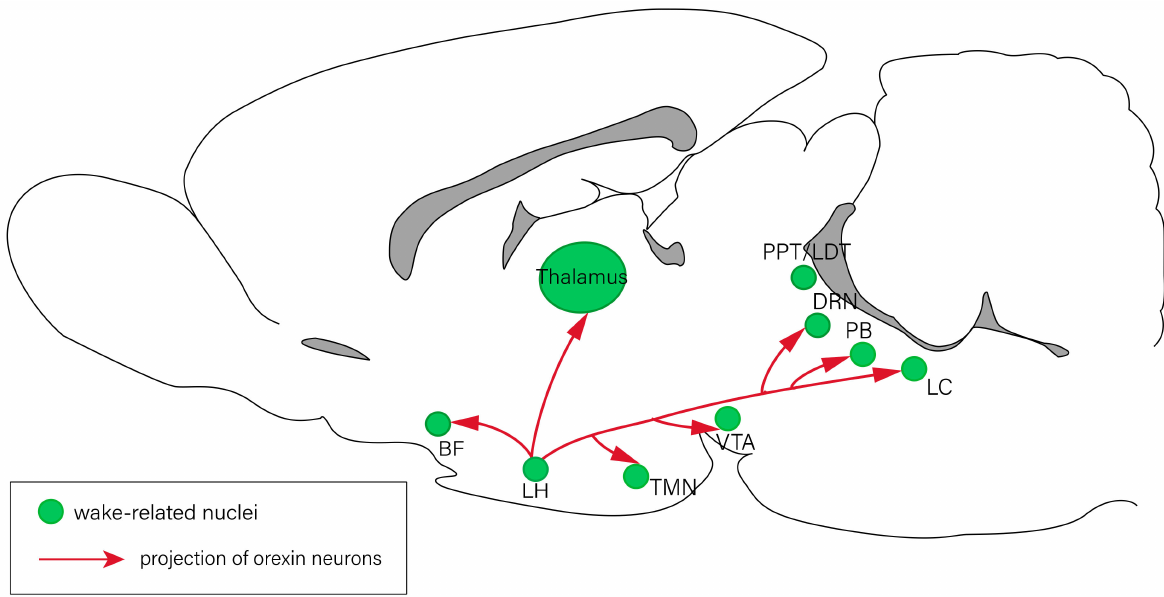
Figure 1. Neural circuits of arousal regulation. The nuclei related to arousal response include the BF, LH, TMN, VTA, PPT/LDT, DRN, PB, and LC. Red lines represent the projections of orexin neurons in the LH. BF: basal forebrain; DRN: dorsal raphe nucleus; LC: locus coeruleus; LDT: laterodorsal tegmental nucleus; LH: lateral hypothalamus; PB: parabrachial nucleus; PPT: pedunculopontine tegmental nucleus; TMN: tuberomammillary nucleus; VTA: ventral tegmental